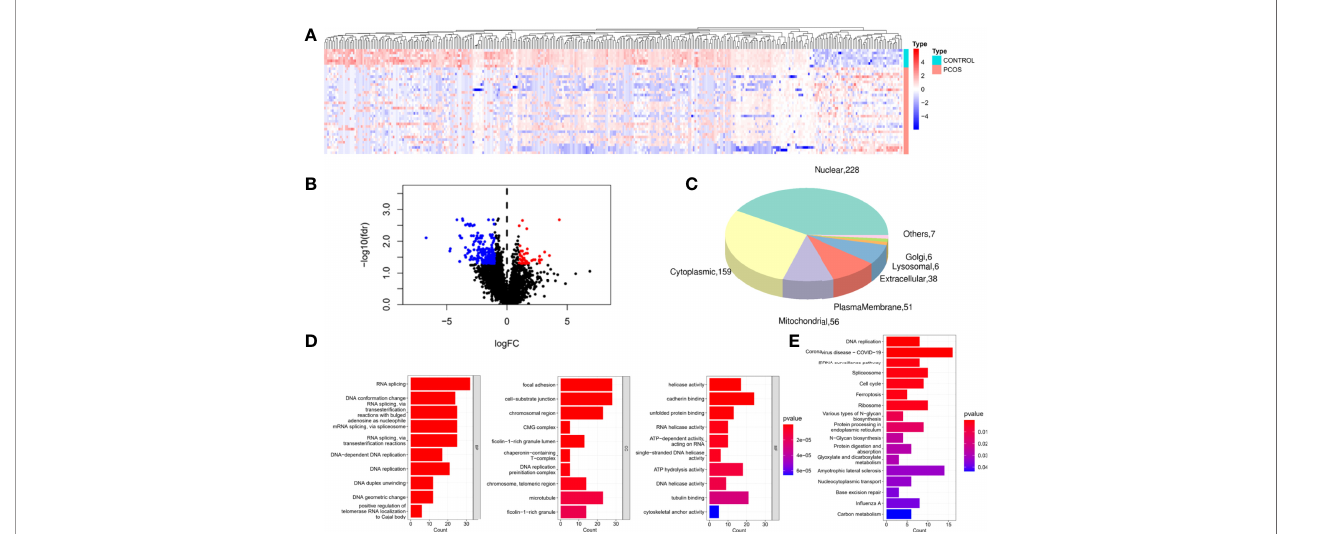
FIGURE 2 | Identi fi cation and functional enrichment of